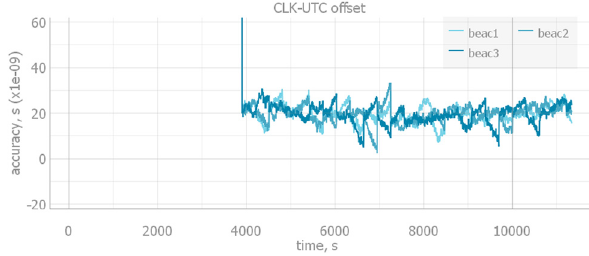
Figure 13: O ff set between beacon clocks and UTC.